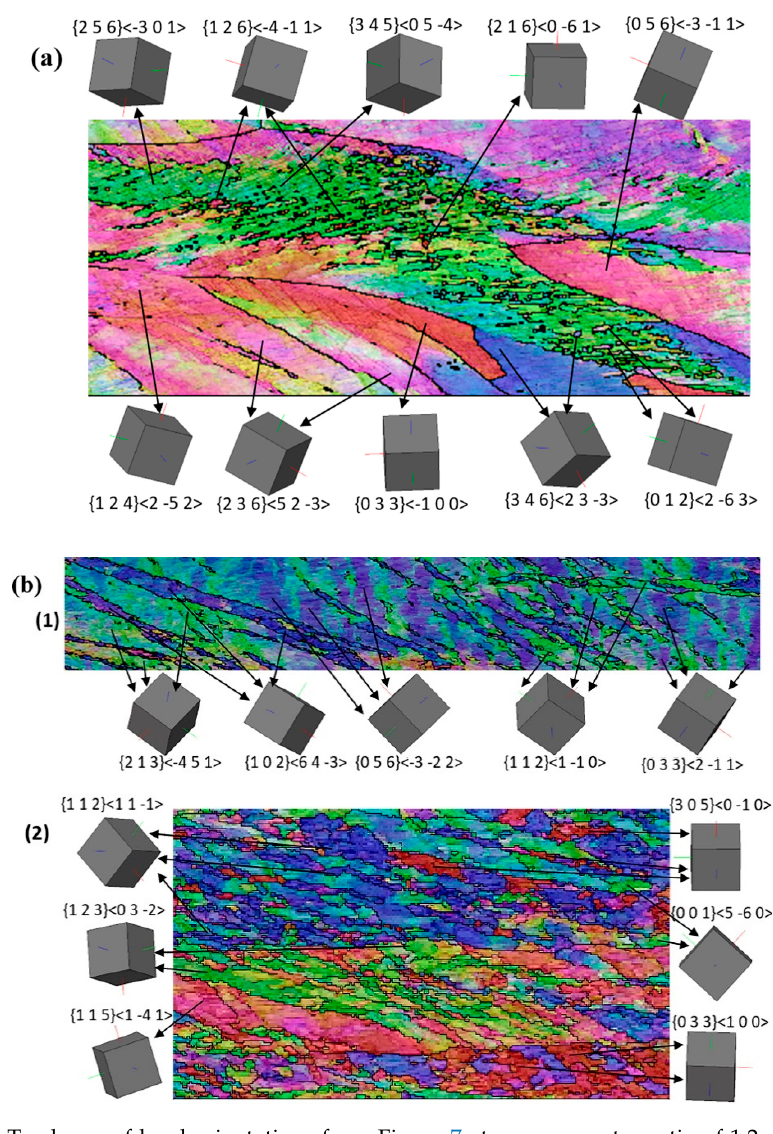
Figure 14. Tendency of local orientations from Figure 7 at an asymmetry ratio of 1:2, ( a ) elliptical marked area 1 at TRPP of 50%, and ( b ) areas 1 and 2 at TRPP of 65%.